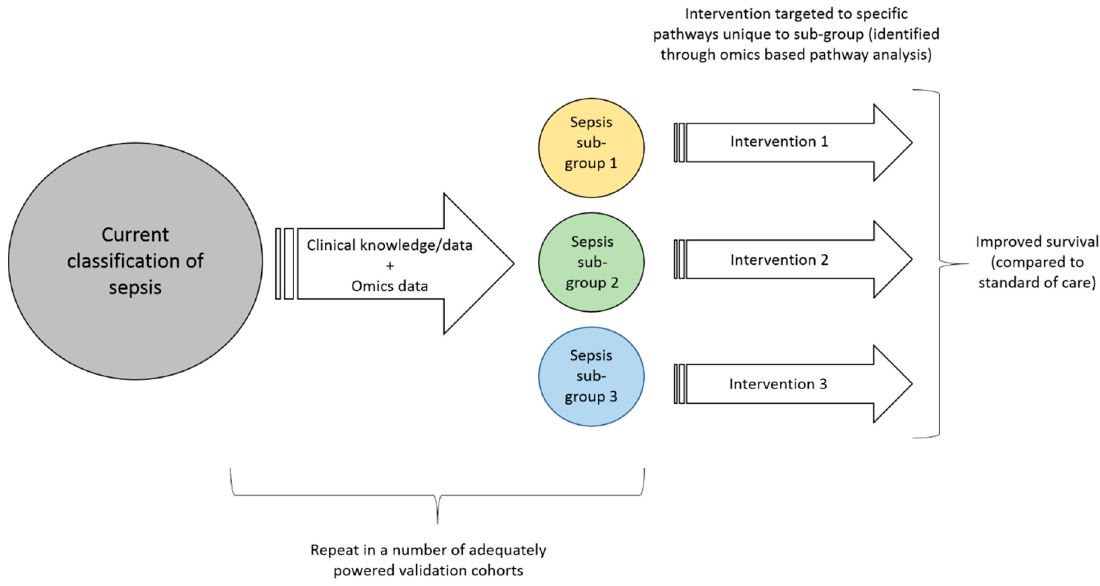
Figure 1. Healthcare 2018 , 6 , x FOR PEER REVIEW